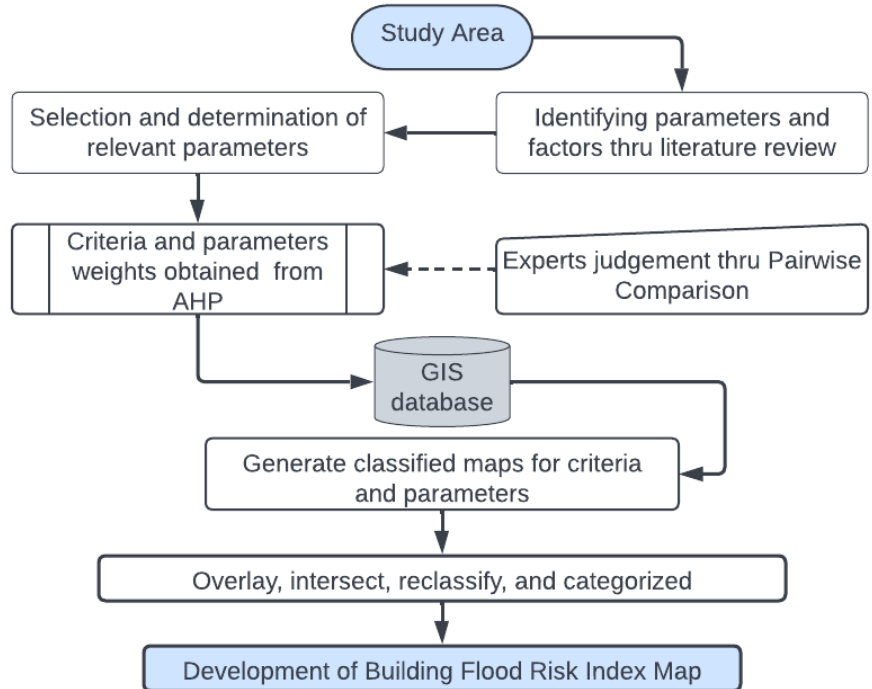
Figure 2. The study’s methodological framework in assessing building flood risk.